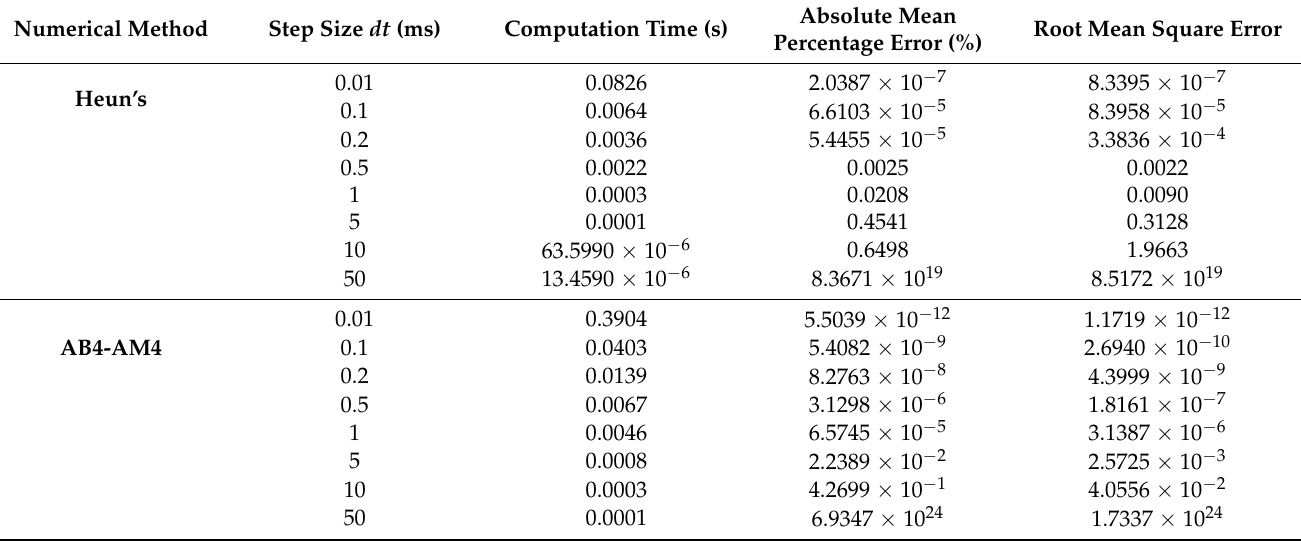
Table 2. Heun’s method and AB4-AM4 comparative analysis for DC